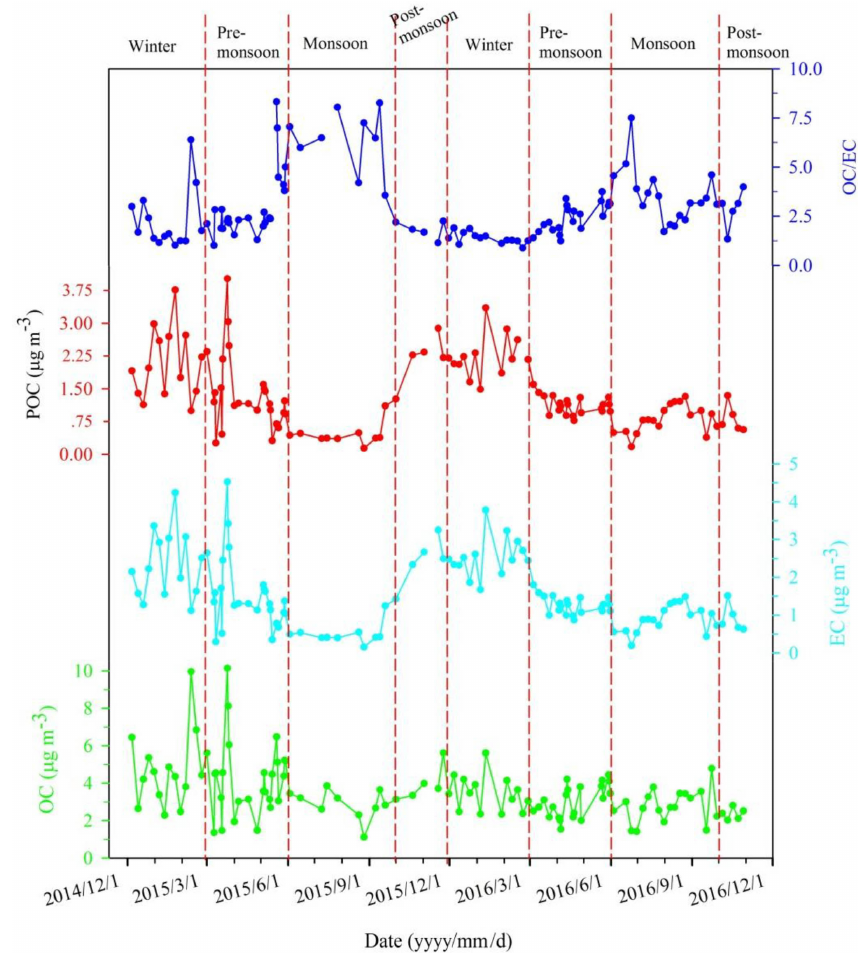
Figure 5. Seasonal variations of EC, OC, and POC concentrations and the OC / EC ratio from GHZ basin during December 2014–December 2016. Table 1. Statistical results of EC, OC, and POC concentrations (µgm − 3 ) and the OC / EC ratios in aerosol from Mt. Yulong during